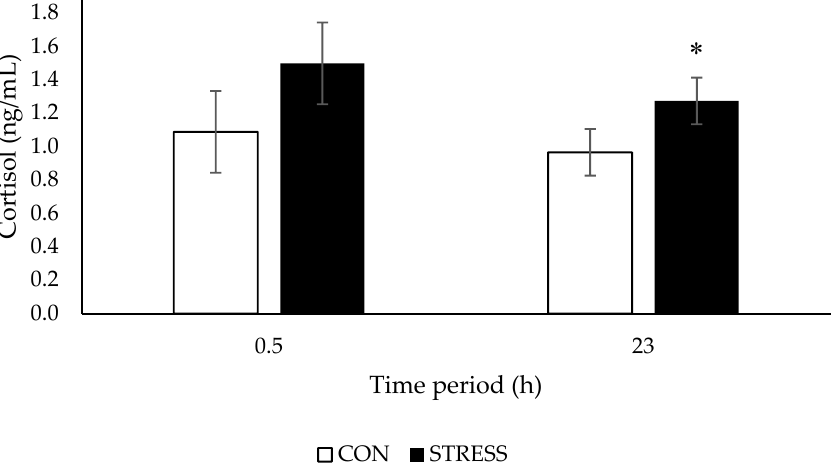
Figure 4. Cortisol concentrations (ng/mL; means ± SED) of ewes housed in control (CON) or visually isolated pens (STRESS) after a 0.5 h and a 23 h test period. * For a time period, least square means differ at p < 0.05.